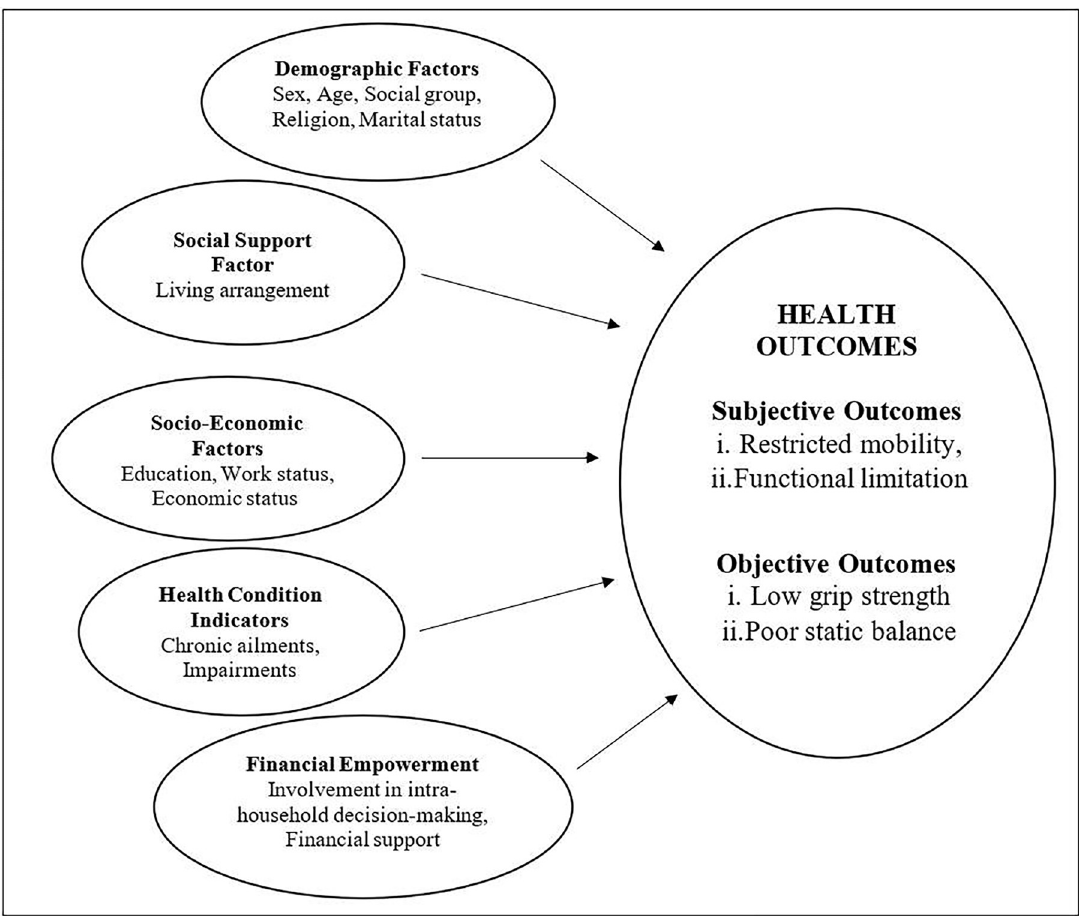
Fig 1. The conceptual framework of determinants of health